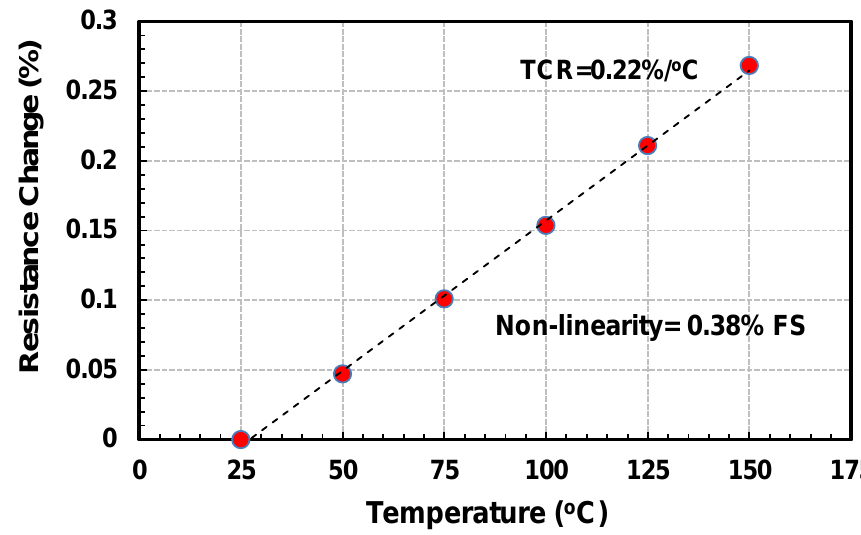
Figure 5. Temperature coefficient of resistance (TCR) of the tungsten based MEMS hot-film flow sensor. Current-Voltage ( I − V ) and Power-Temperature ( P − T ) curves for all sensors are plotted to evaluate their electro-thermal characteristics. I − V curves for the four hot-film sensors having square membrane (i.e., FS1, FS3, FS5 and FS7 with MHR = 1, 2, 3 and 4, respectively) are shown in Figure 6 while their P − T curves are depicted in Figure 7.